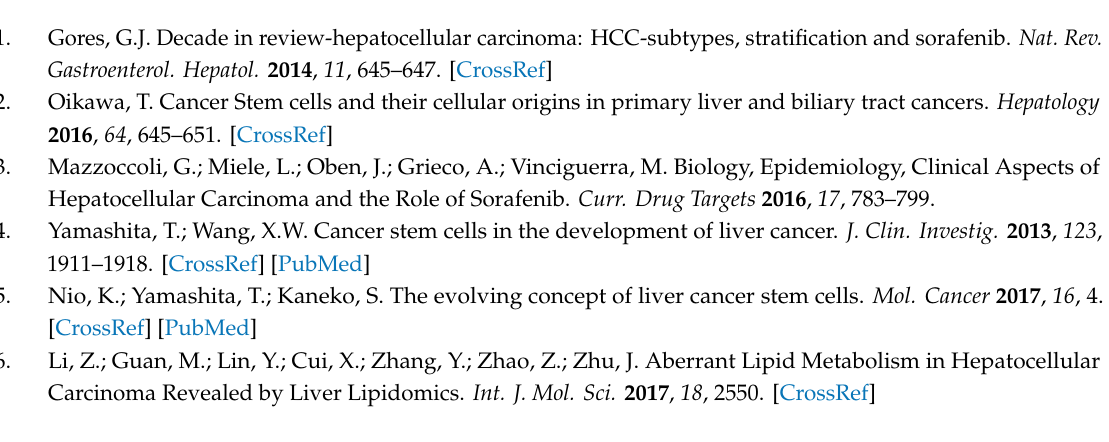
Figure S9. PLS-DA cross validation result for HepG2 cells depleted for FAK. Table S1. MRM-profiling method in positive and negative ion